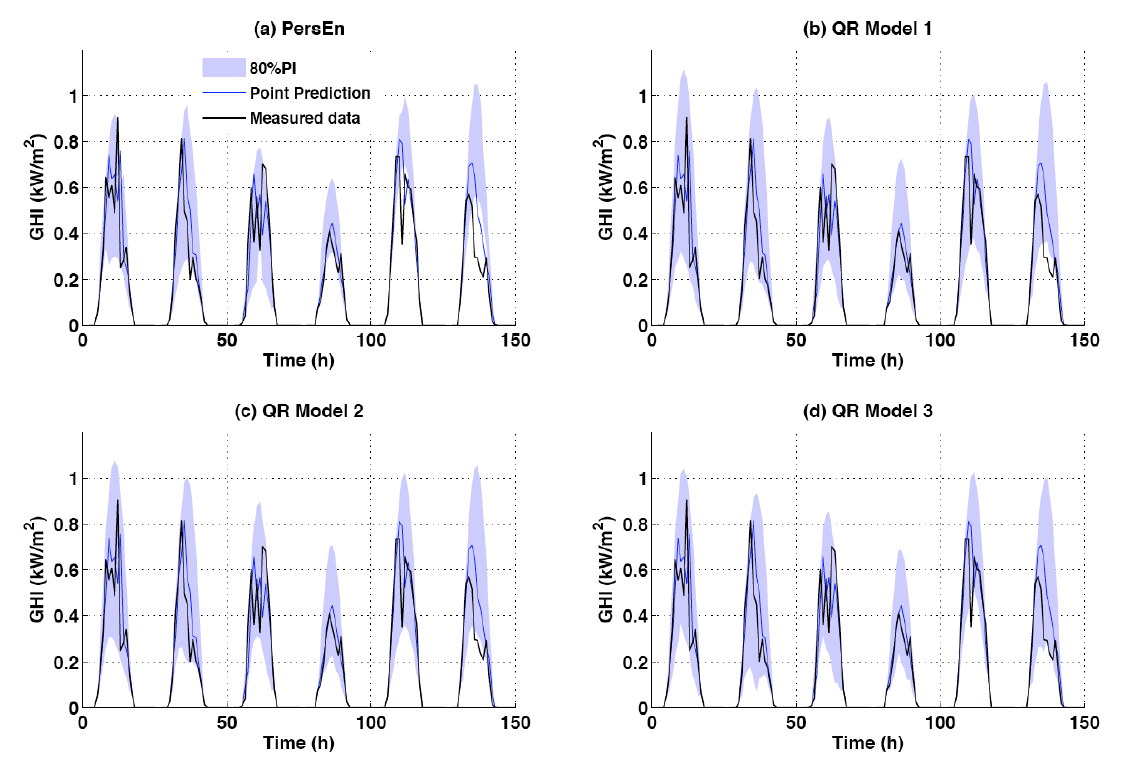
Figure 9. Measured and forecasted GHI time series and the corresponding 80%PI calculated by the four models for a lead time of 6 h. The graphs shows six days that cover different weather conditions in the testing dataset. ( a ) PersEns Model; ( b ) QR Model 1; ( c ) QR Model 2; ( d ) QR Model